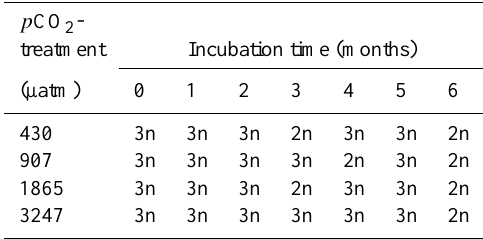
Table 1. Replication (n) scheme for the measured parameters of population density/abundance, size class proportion, test diameter and CaCO 3 weight of Ammonia aomoriensis for four p CO 2 treat- ments during 6 months of incubation